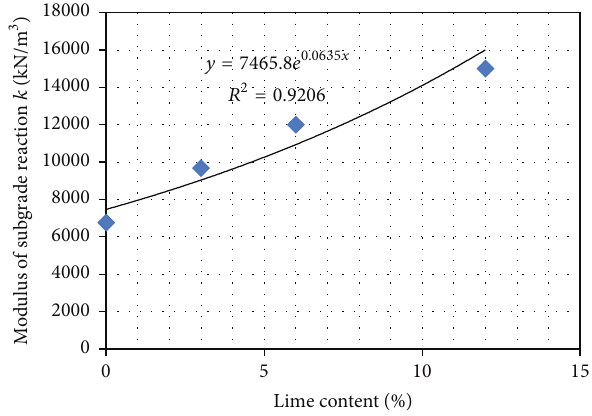
Table 6: Modulus of subgrade reaction.